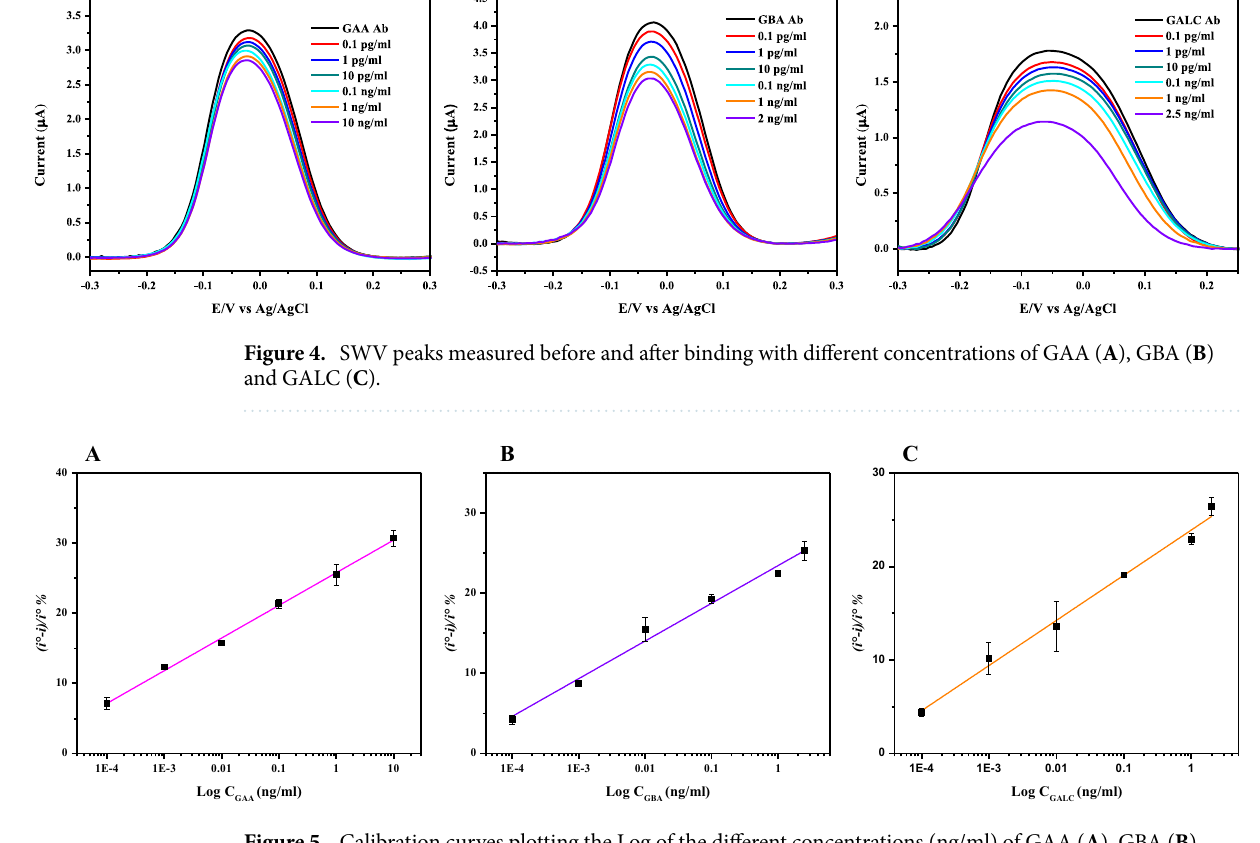
Figure 5. Calibration curves plotting the Log of the different concentrations (ng/ml) of GAA ( A ), GBA ( B ) and GALC ( C ) versus the immunosensor’s response ((i° − i)/i° %). Error bars show the standard deviation of the